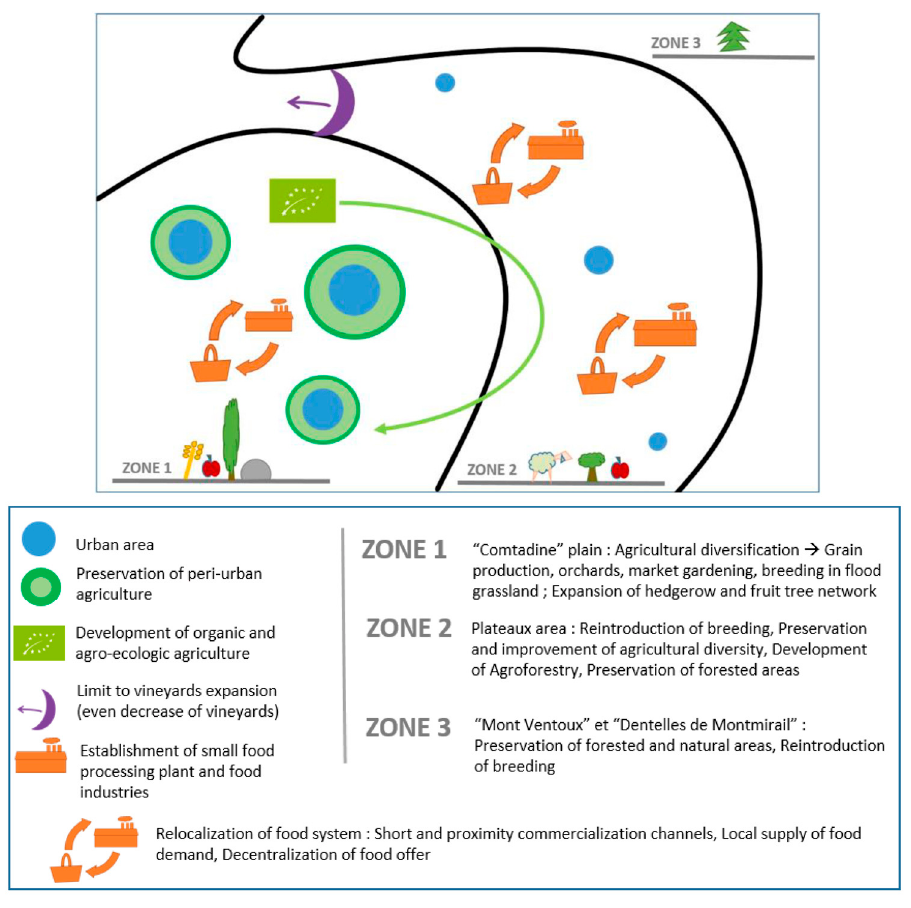
Figure 8. Synthetic and chromatic map of the